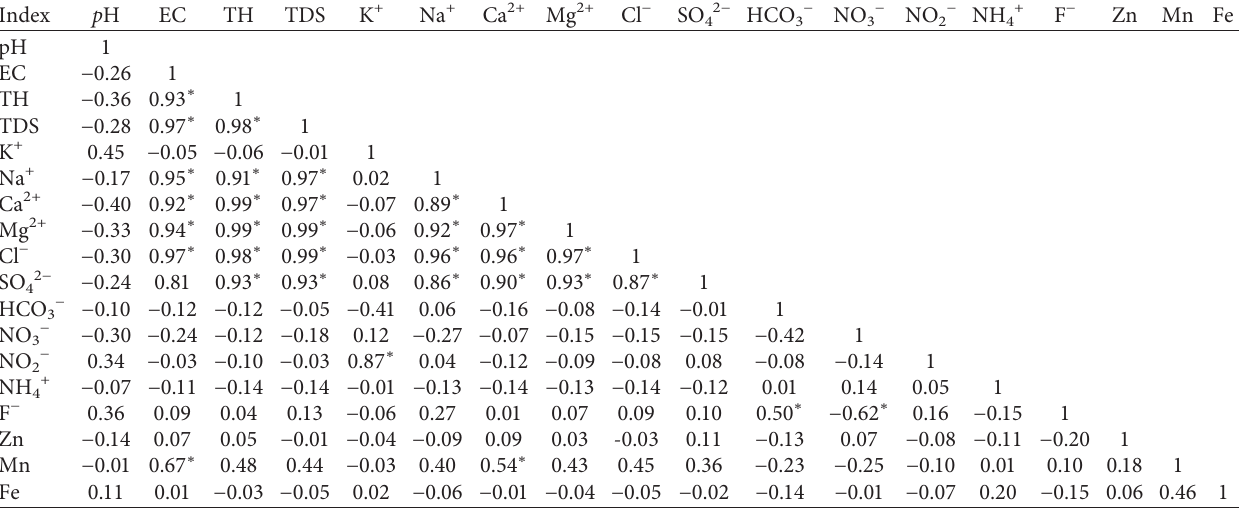
Table 2: Linear relationship (R2) between various chemical parameters of groundwater in the study